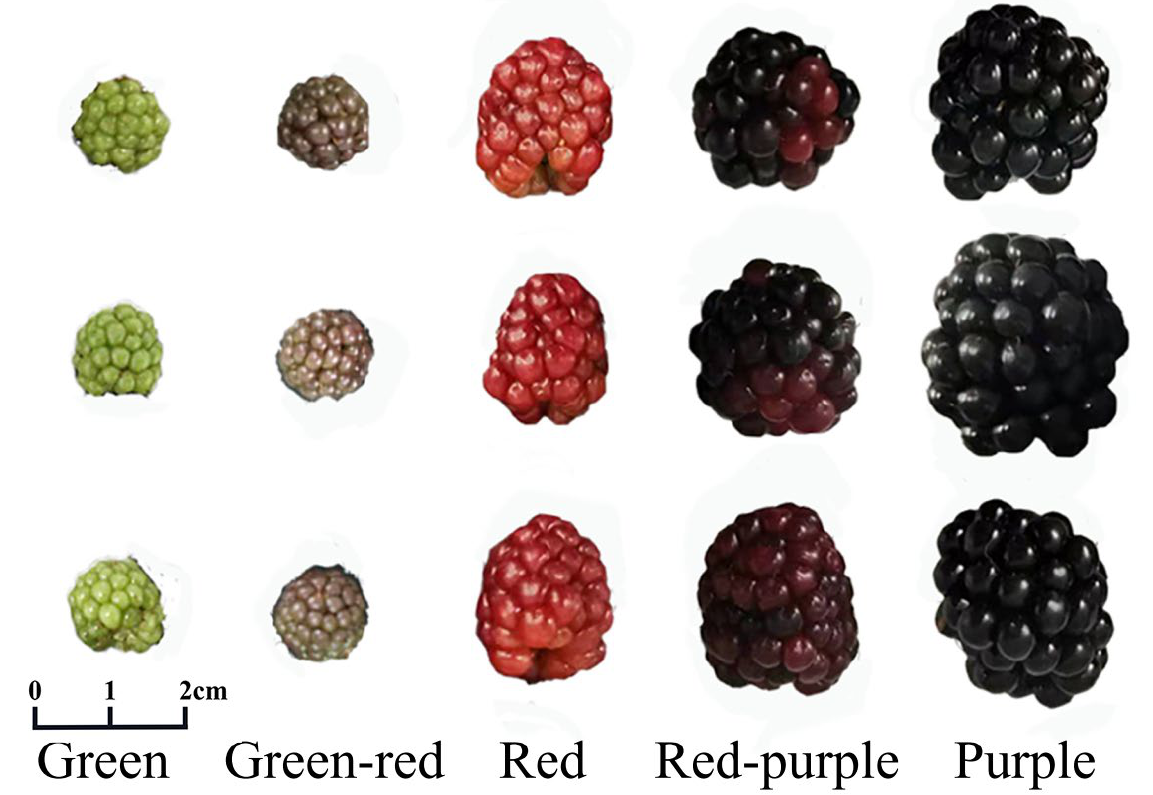
Figure 8. Appearance of blackberry cv. ‘Chester’ fruits at various developmental stages. According to the color of the fruit, the development of the fruit can be divided into five stages: green fruits, green–red fruits, red fruits, red–purple fruits, and purple fruits.